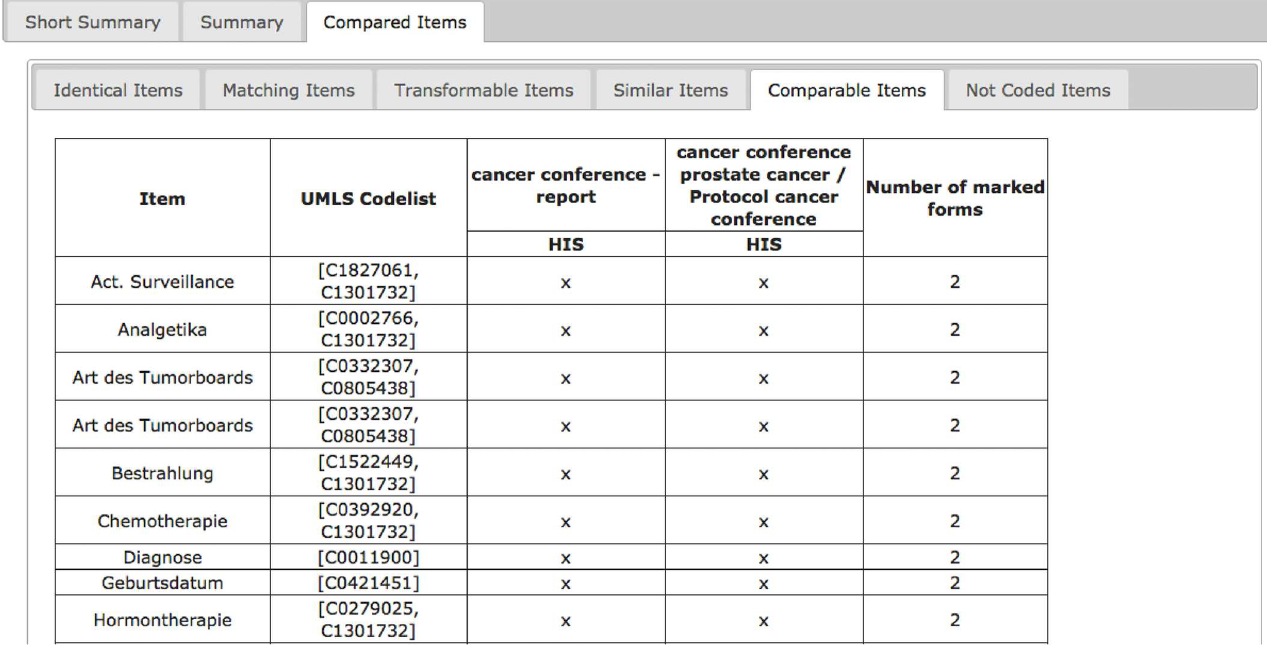
Fig 12. Comparable Items of forms for the same domain (cancer) from different institutions. The comparableitems are “Act. Surveillance”, “Analgesics”, “Type of the Tumour Board”, “Irradiation”, “Chemotherapy”, Diagnosis”, Birthdate” and “Hormone therapy”.